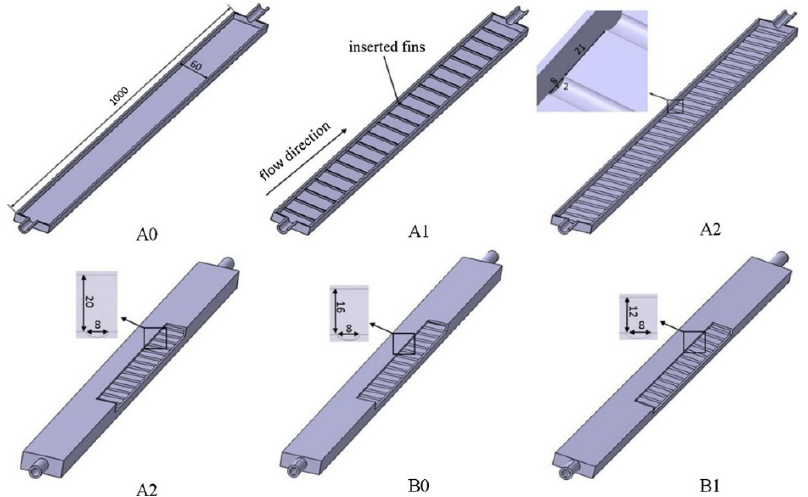
Figure 23. Cooling units with five different inner topologies—empty, fins and grooves with different channel heights (units: mm). Reprint with permission [97]; Copyright 2021, Springer Nature.